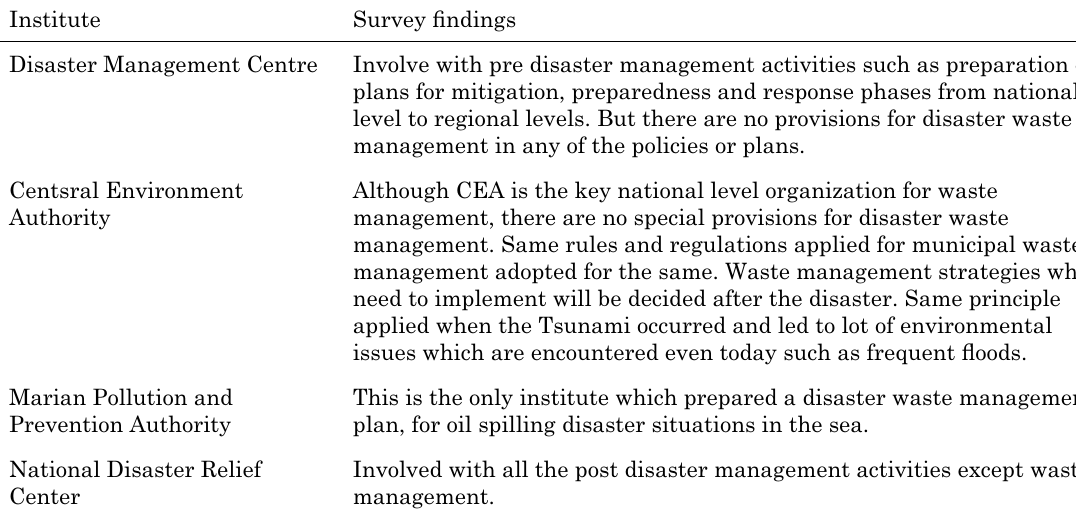
Table 3. Summarized fi ndings of pilot survey